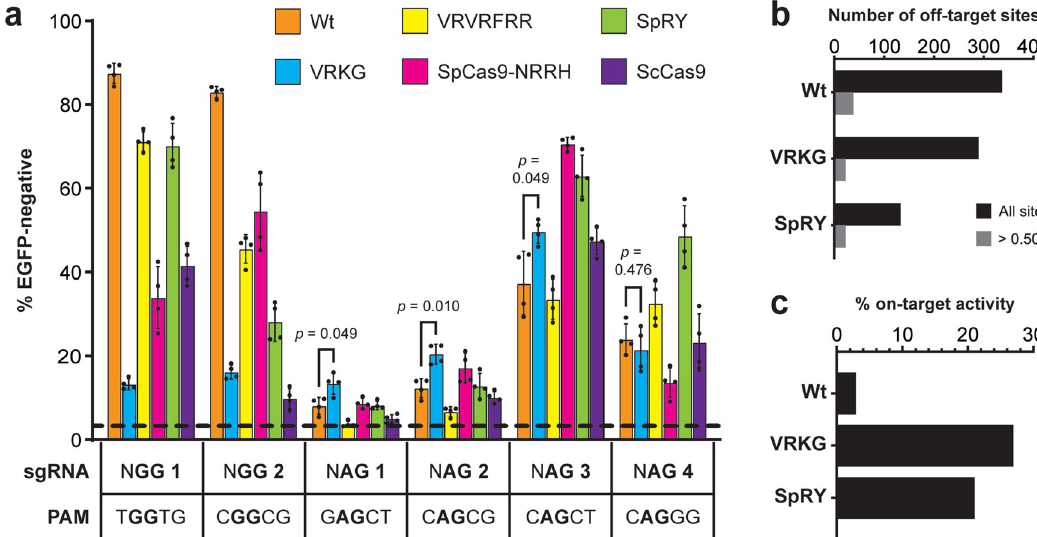
Fig. 5 Comparison of VRKG with Wt Cas9 and other NAG-permissive variants in human cell culture targeting assays. a Disruption of a chromosomally integrated constitutive EGFP cassette in the U2OS background, using catalytically active wild-type or engineered variants with NGG- or NAG-targeting sgRNAs as indicated. EGFP knockdown activity is plotted as the percentage of EGFP-negative cells, determined from transiently transfected populations of single cells analyzed by fl ow cytometry. sgRNA sequences and nomenclature were designed previously 7 . p values calculated from two-tailed t tests comparing Wt Cas9 and VRKG with each NAG-targeting sgRNA are shown. Error bars, mean ± s.d. ( n = 4, biological replicates). Black dashed line denotes the EGFP-negative background level determined from experiments with a non-targeting sgRNA. b Quanti fi cation of GUIDE-seq off-target sites detected for Wt Cas9, VRKG, and SpRY with the ‘ HEK site 4 ’ sgRNA in U2OS.EGFP cells. Bars quantify all off-target sites (black bars) or only those off-targets that contributed >0.50% of summed GUIDE-seq read counts (gray bars) detected in each experiment. c Percent on-target activity, determined for each variant from the fraction of their on-target GUIDE-seq read counts out of summed GUIDE-seq reads detected overall. Source data are available in the Source Data fi